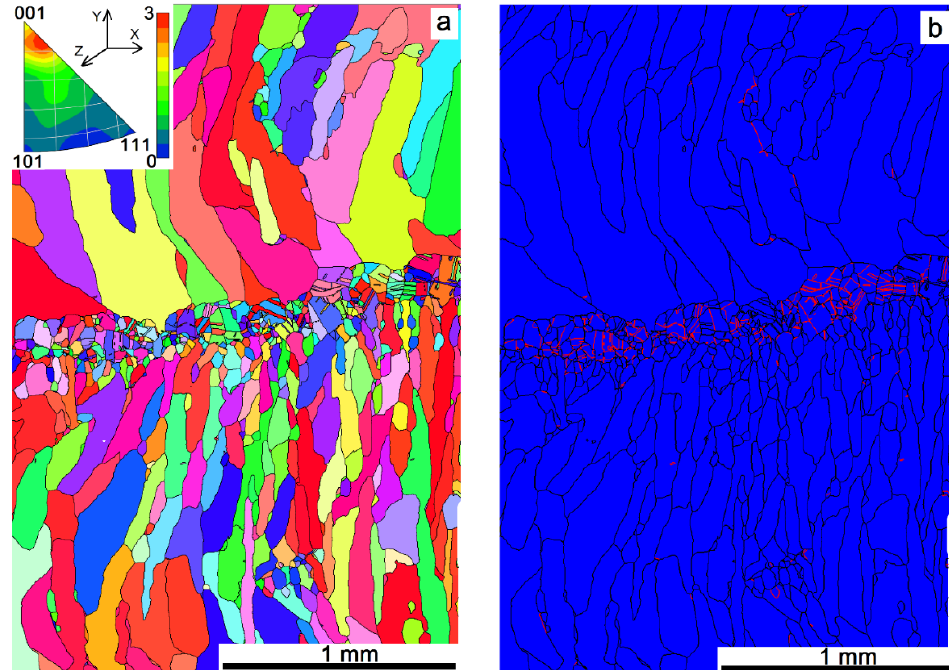
Figure 7. EBSD grain orientation distribution ( a ) and grain boundary types ( b ) in a cross section of the Cu-7.5wt.%Al wall obtained at heat input of 0.21 kJ/mm. Red lines in Figure 7b show the annealing twin boundaries.